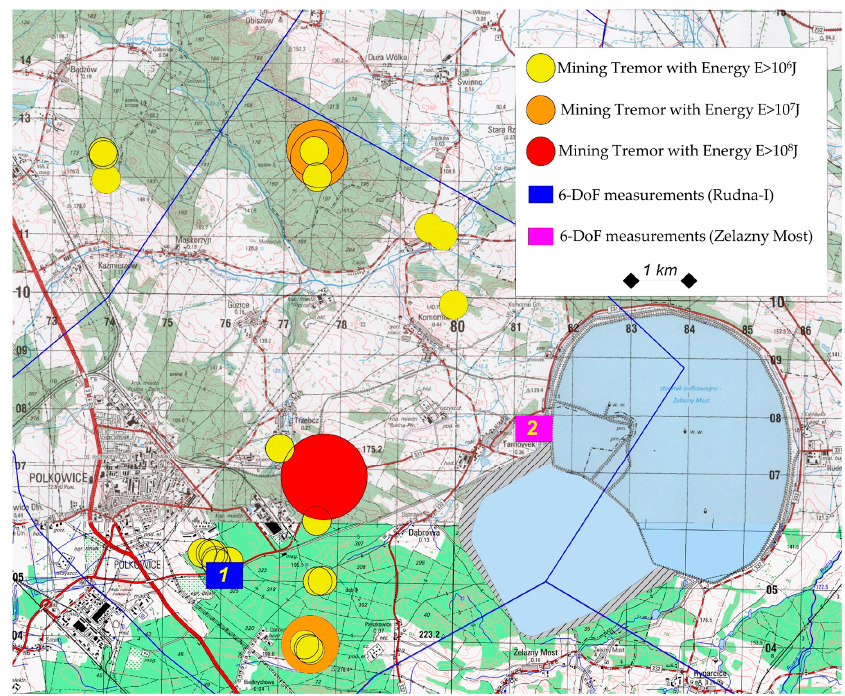
Figure 6. Epicentric location of recorded high-energy